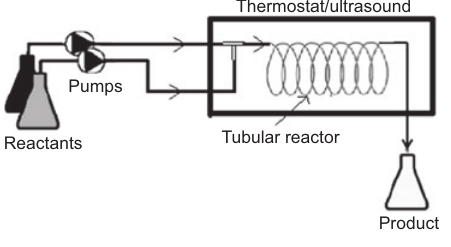
Figure 1 Experimental set-up for continuous fl ow experiments.